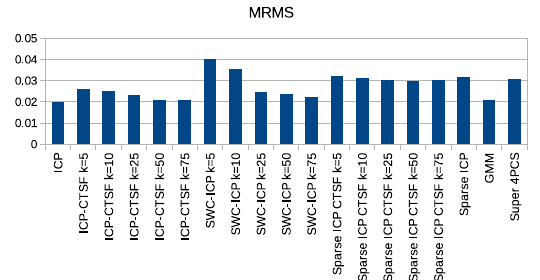
Fig. 17: MRMS of all methods using video sample r = 16 , with ς = 1 .